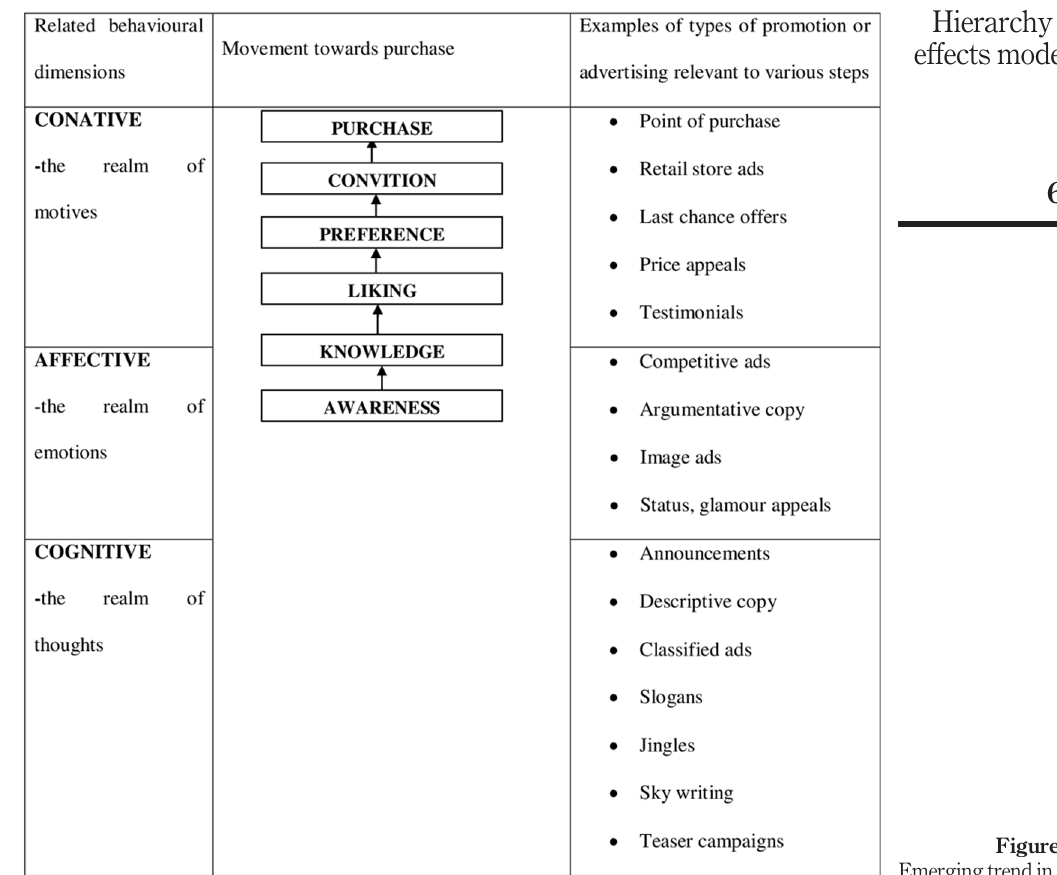
Figure 1. Emerging trend in the pre-connectivity